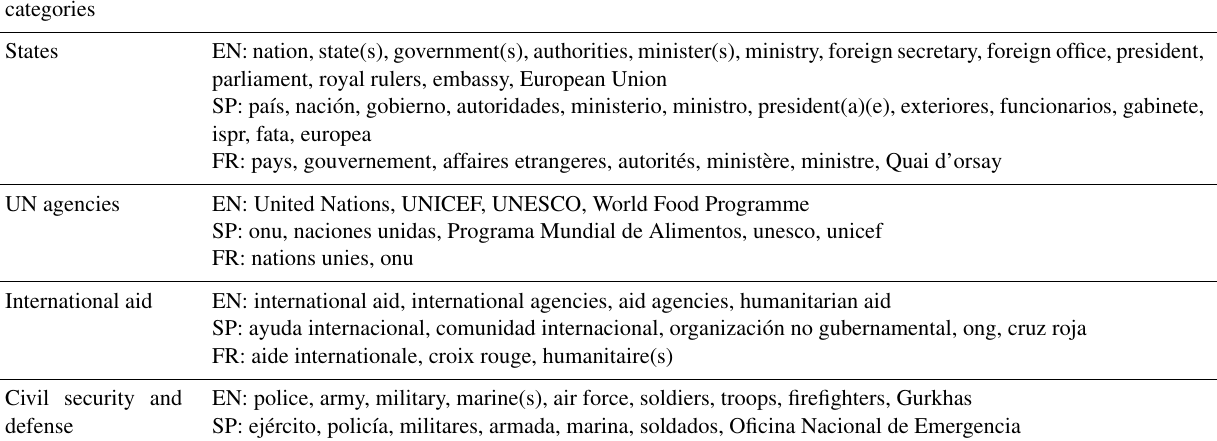
Table 2. Identity matrix. Contains the keywords used to quantify the presence/absence of different categories of stakeholders. Keywords were identified from a list of most frequent words using different thresholds for English (EN), Spanish (SP) and French (FR) to balance differences in the RSS feed